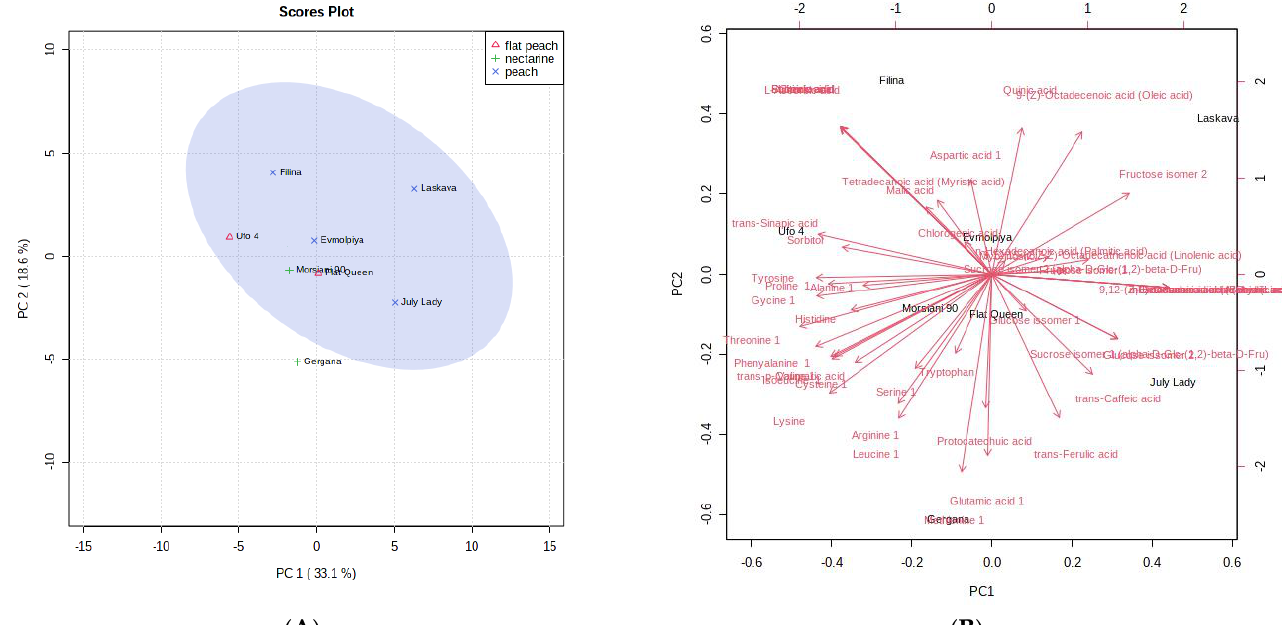
Figure 3. Principal component score plot ( A ) and eigenvector load values ( B ) of GC-MS data of volatile compounds of peach ( Prunus persica L.) peels for the eight peach peel